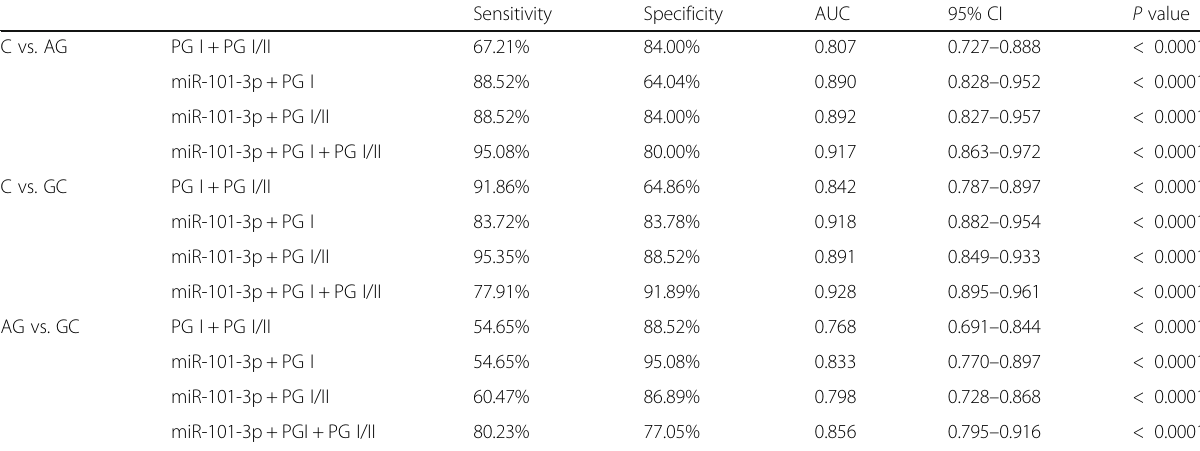
Table 4 The diagnostic value of serum marker combinations on atrophic gastritis (AG) and gastric cancer (GC)